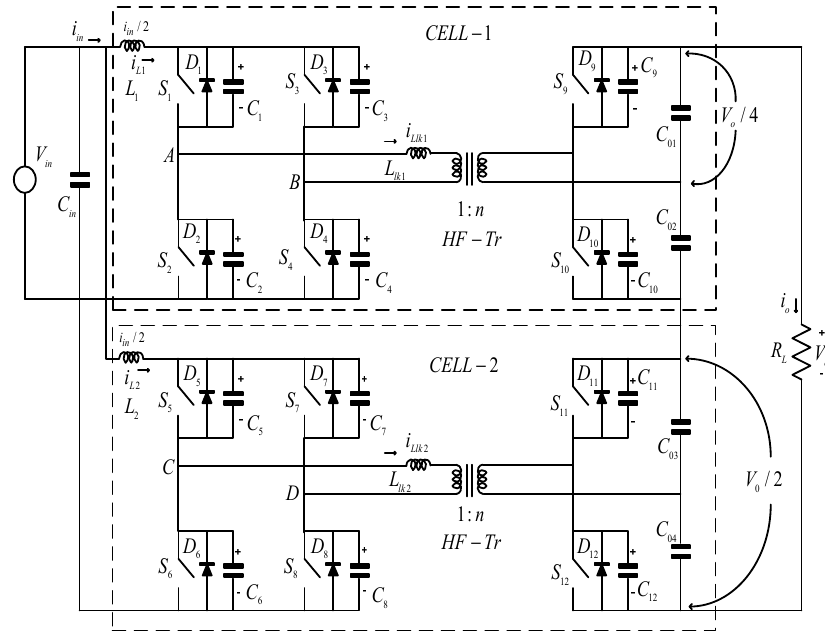
Figure 12. Proposed interleaved ZCS current–fed full–bridge dc/dc converter [26].